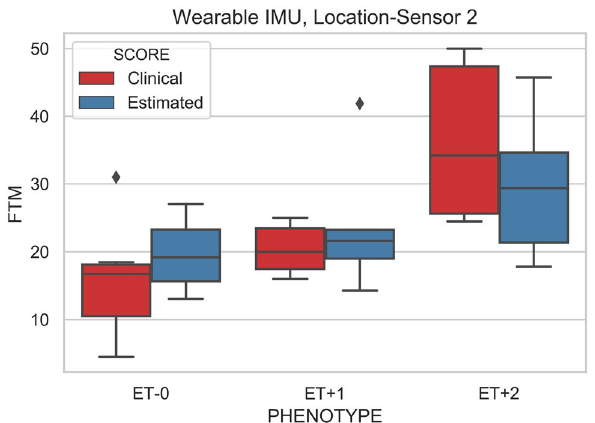
Figure 4. Shows the ET Phenotype of the clinical and estimated FTM scores.